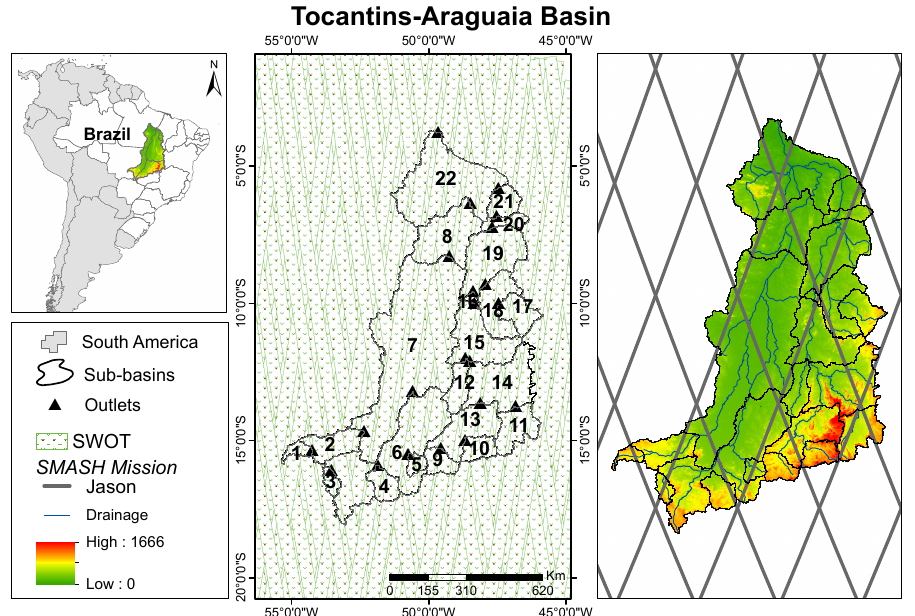
Figure 1. ( Left ) Location of Tocantins-Araguaia Basin with its topography; ( middle ) sub-basin catchments (see Table 1 for details) and their outlets along with the ground-tracks of the SWOT mission; ( right ) drainage network along with the ground-tracks of the SMASH mission (equivalent here to Jason